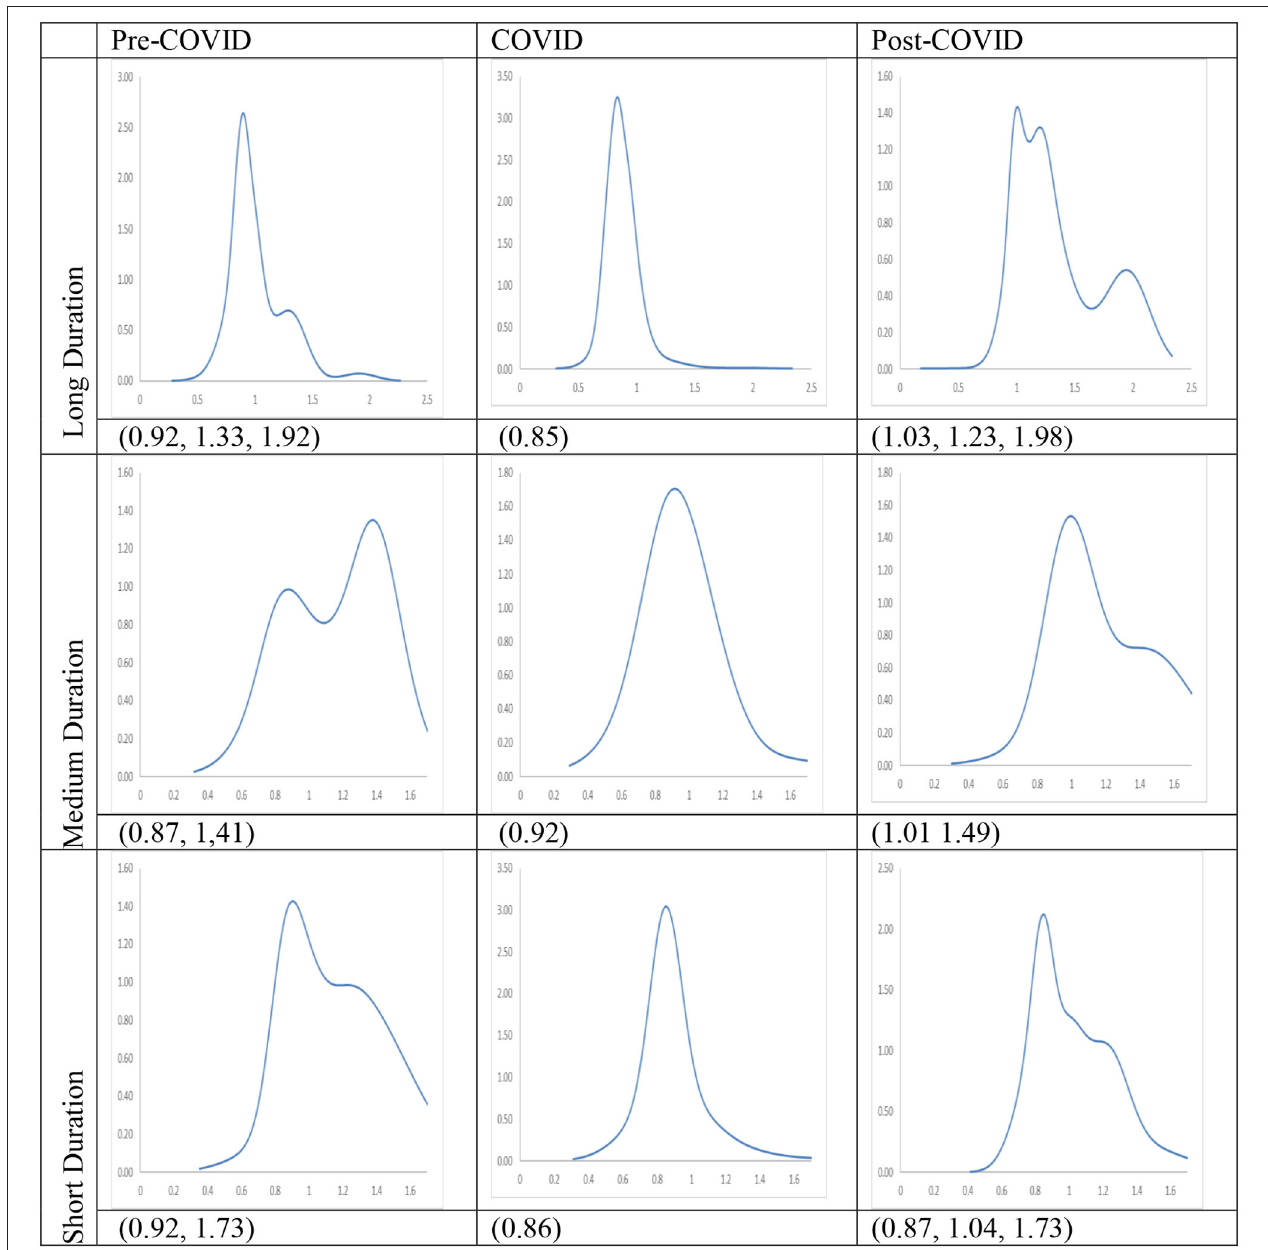
FIGURE 11 | Ergodic distributions for the RDIPC of urban residents in cities with long, medium, and short duration of Level I ERS. Source: authors’ calculation. N.B. The vertical axis indicates the density of probability, the horizontal axis indicates RDIPC values, and the value of the peaks are in